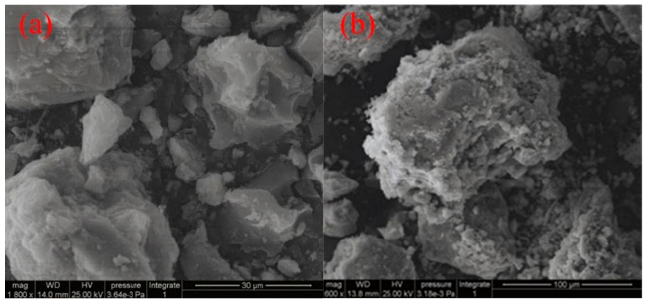
Figure 2. SEM images of ( a ) SAC and ( b ) SBAC.